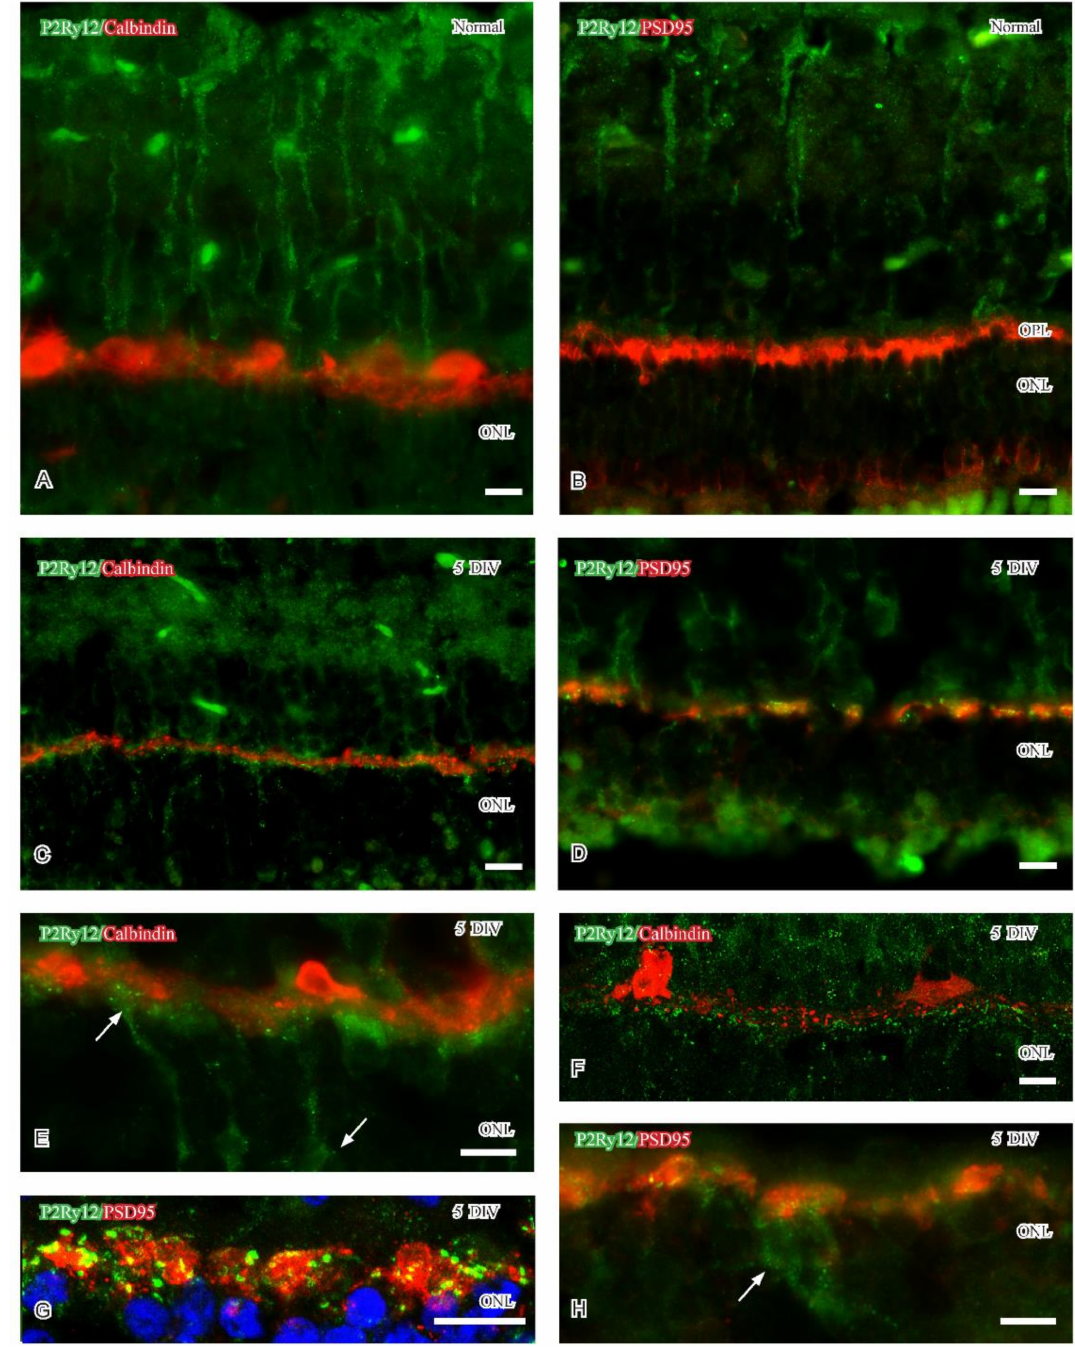
Figure 2. Confocal stacks ( F , G ) and fluorescence micrographs ( A – E , H ) showing P2Ry12 immunore- activity (green) in normal and 5 DIV retina. Calbindin or PSD95 immunoreactivity (red) indicate the OPL. ( A , B ) P2Ry12 immunoreactivity is mainly evident in the inner parts of Müller cells. ( C , E , F ) Co- labeling with calbindin shows that P2Ry12 immunoreactivity distributes close to horizontal cell processes at 5 DIV. ( E ) Structures resembling cone photoreceptor terminals occasionally expressed P2Ry12 immunoreactivity. ( D , G ) Juxtaposed P2Ry12 and PSD95 immunoreactivities in the OPL (yellowish hue in ( D )). ( H ) P2Ry12 immunoreactive microglial cells (arrow) and processes in the PSD95 labeled OPL. Abbreviations as in Figure 1. Scale ( A – H ) 10 µ